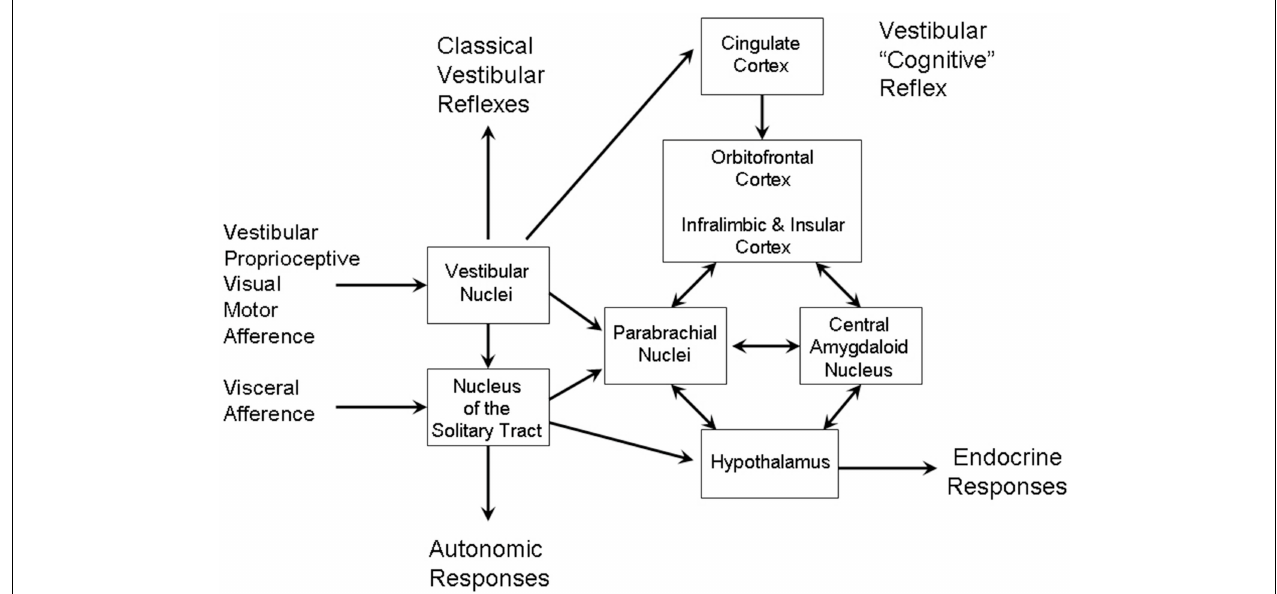
FIGURE 8 | The vestibular-parabrachial pathways that mediate the vestibular autonomic reflex. Adapted from Figure 1 of Balaban (2002).